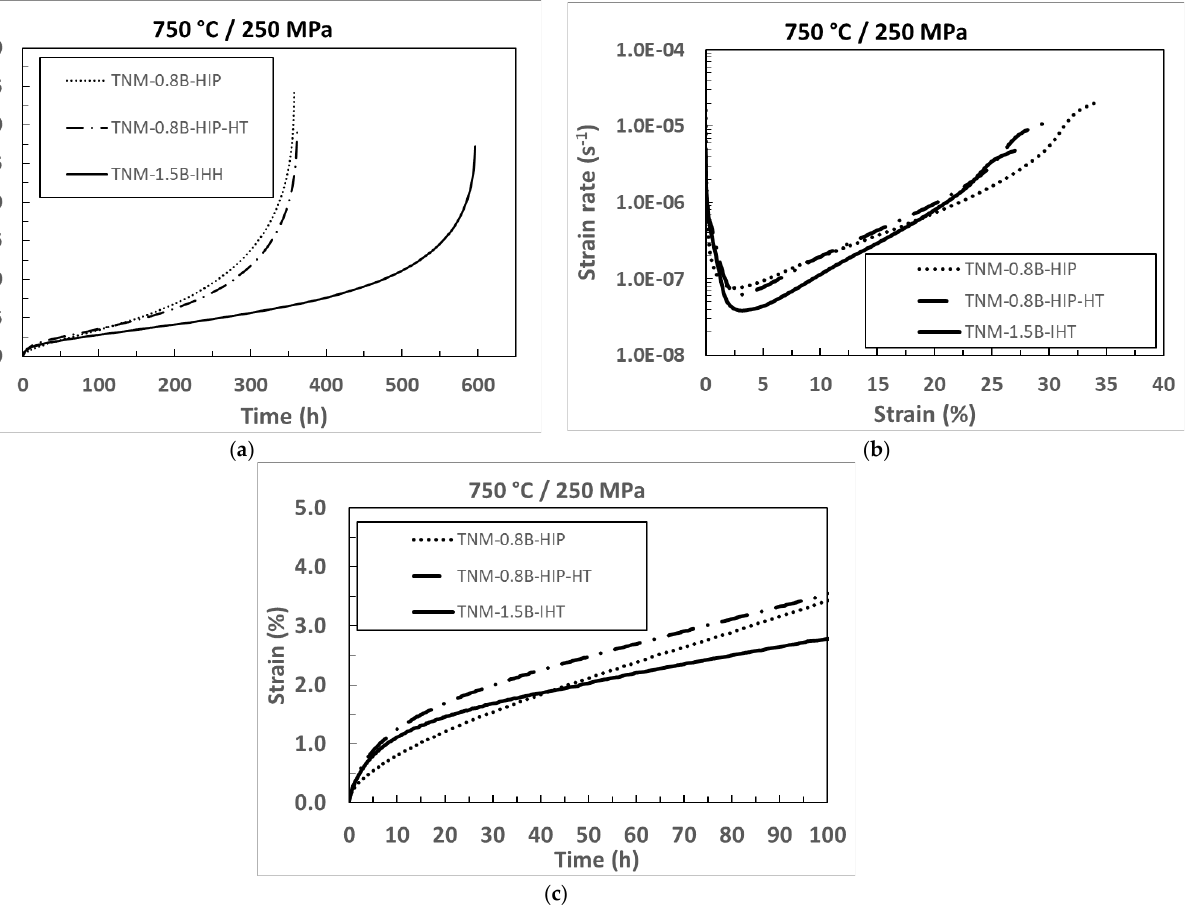
Figure 6. Creep results of the three manufactured samples; ( a ) Creep strain versus time; ( b ) Strain rate versus strain; and ( c ) Creep strain versus time up to 100 h, (detailed from figure ( a